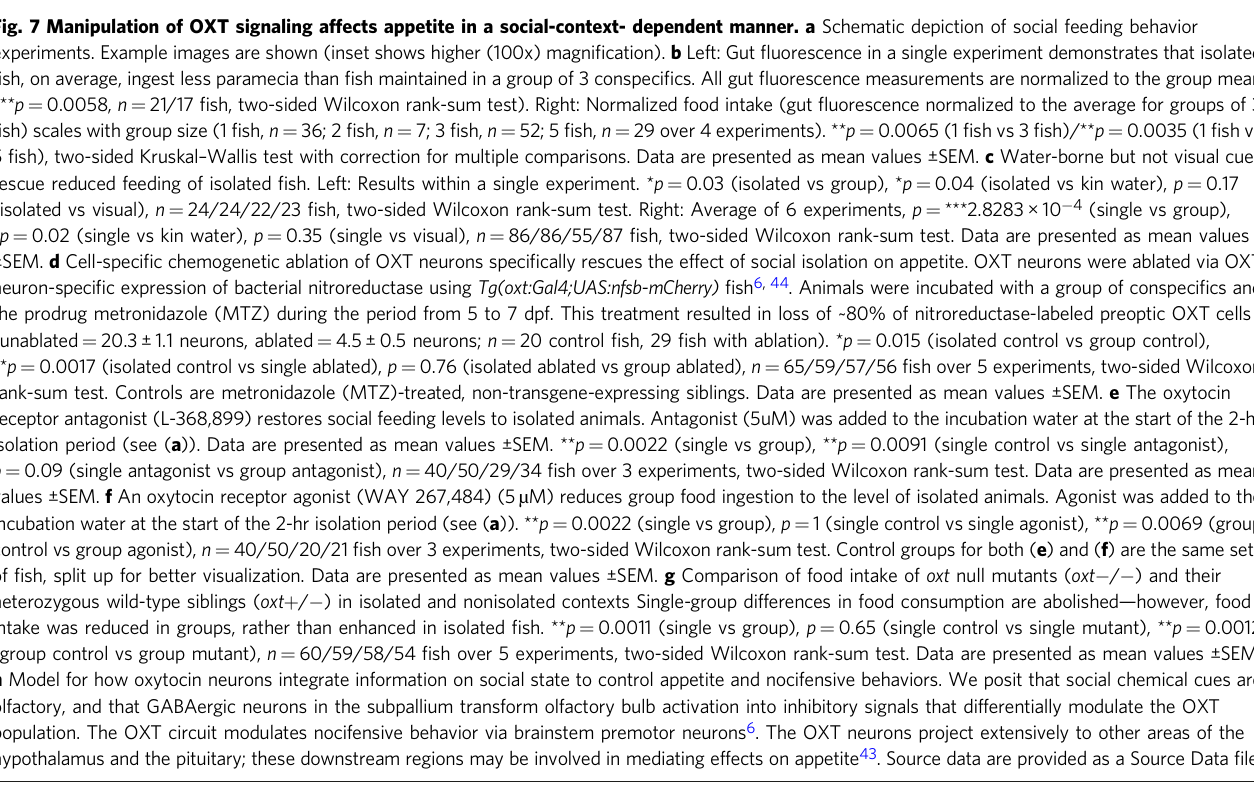
Fig. 7 Manipulation of OXT signaling affects appetite in a social-context- dependent manner. a Schematic depiction of social feeding behavior experiments. Example images are shown (inset shows higher (100x) magni fi cation). b Left: Gut fl uorescence in a single experiment demonstrates that isolated fi sh, on average, ingest less paramecia than fi sh maintained in a group of 3 conspeci fi cs. All gut fl uorescence measurements are normalized to the group mean (** p = 0.0058, n = 21/17 fi sh, two-sided Wilcoxon rank-sum test). Right: Normalized food intake (gut fl uorescence normalized to the average for groups of 3 fi sh) scales with group size (1 fi sh, n = 36; 2 fi sh, n = 7; 3 fi sh, n = 52; 5 fi sh, n = 29 over 4 experiments). ** p = 0.0065 (1 fi sh vs 3 fi sh)/** p = 0.0035 (1 fi sh